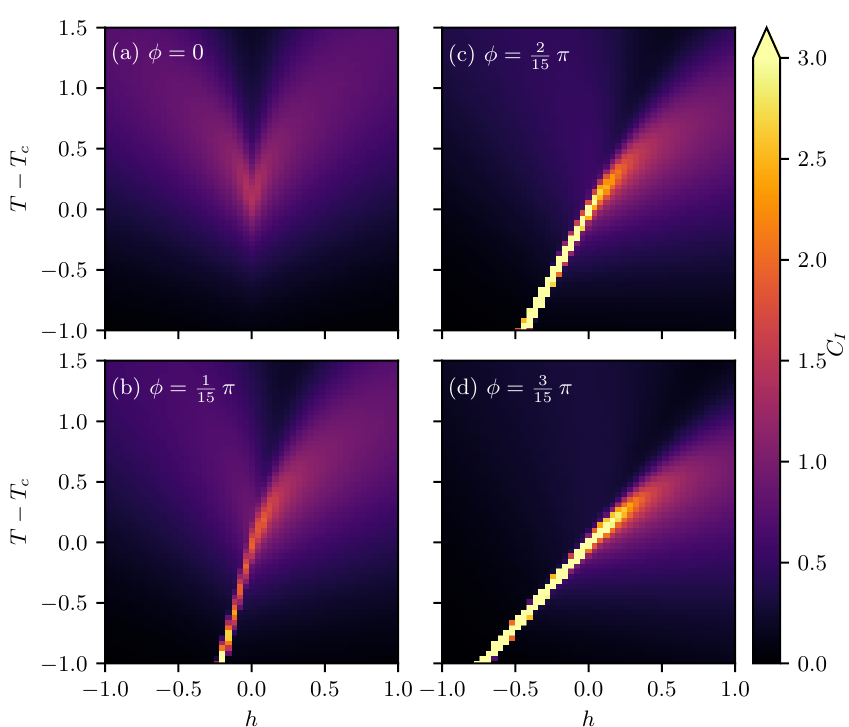
( T , h ) , of the bare L = 12 Ising model in rotated coordi- Figure 7: Specific heat, C I nates, shown for different values of the mixing angle, φ , between the bare coordi- nates ˜ T and ˜ h